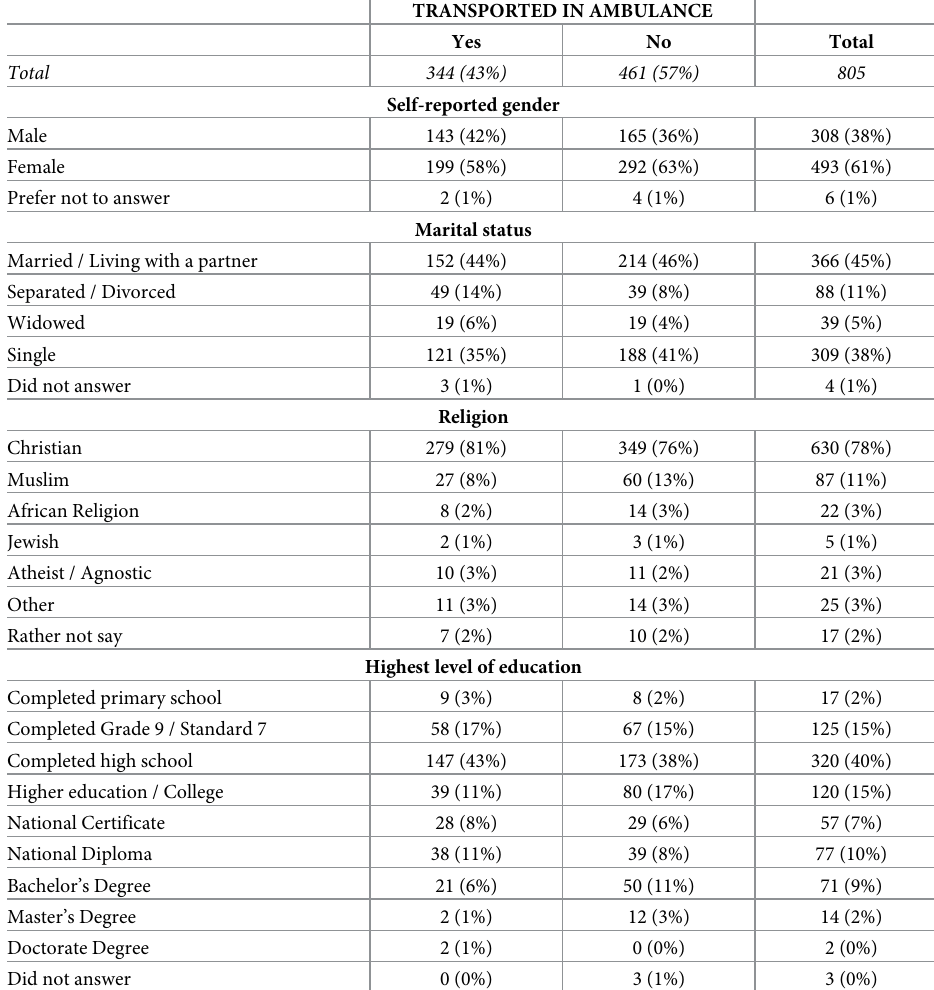
Table 1. Demographic details of